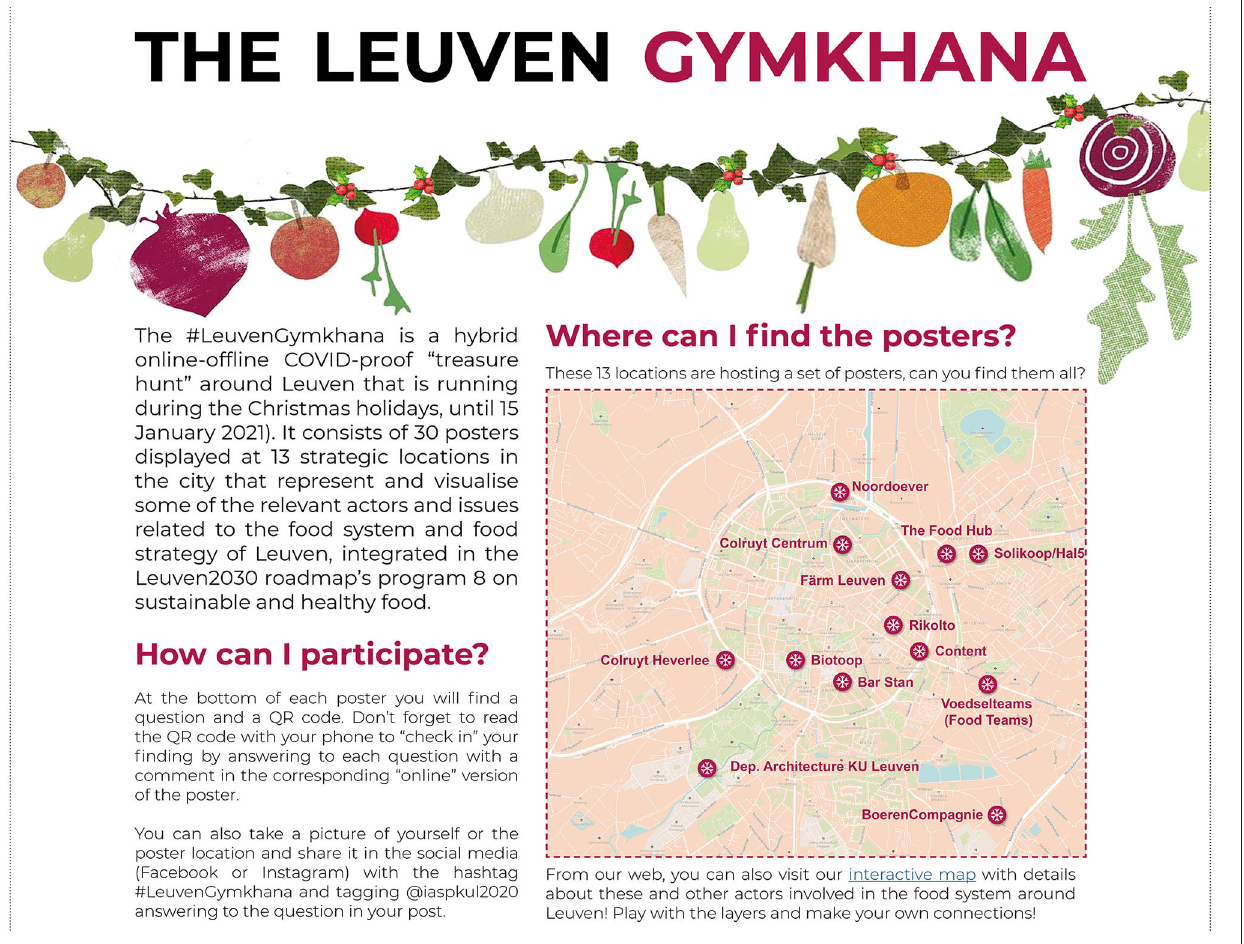
FIGURE 3 | Crop from the LeuvenGymkhana advertising poster showing all the partner organizations hosting posters for the treasure hunt.